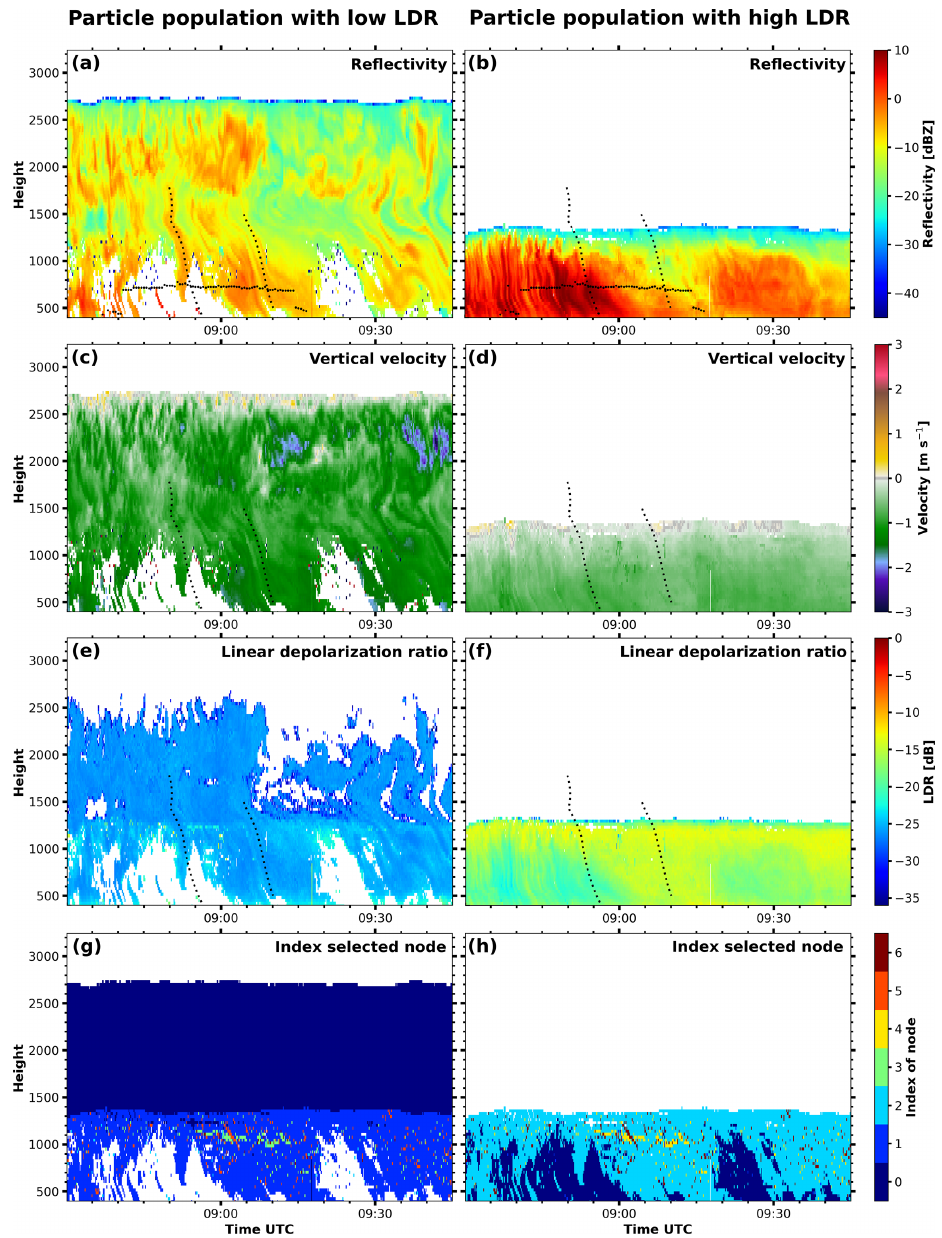
Figure 8. MIRA-35 reflectivity with lidar-detected cloud-base height (black dots, a , b ), mean velocity (c, d) , linear depolarization ratio (LDR; e , f ) and index of the selected node (g, h) of the two particle populations (left and right column) on 29 June 2017 from 08:30 to 09:45UTC. The dashed black lines locate the two fallstreaks described in the text. For regions marked in white no node could be assigned to the respective particle